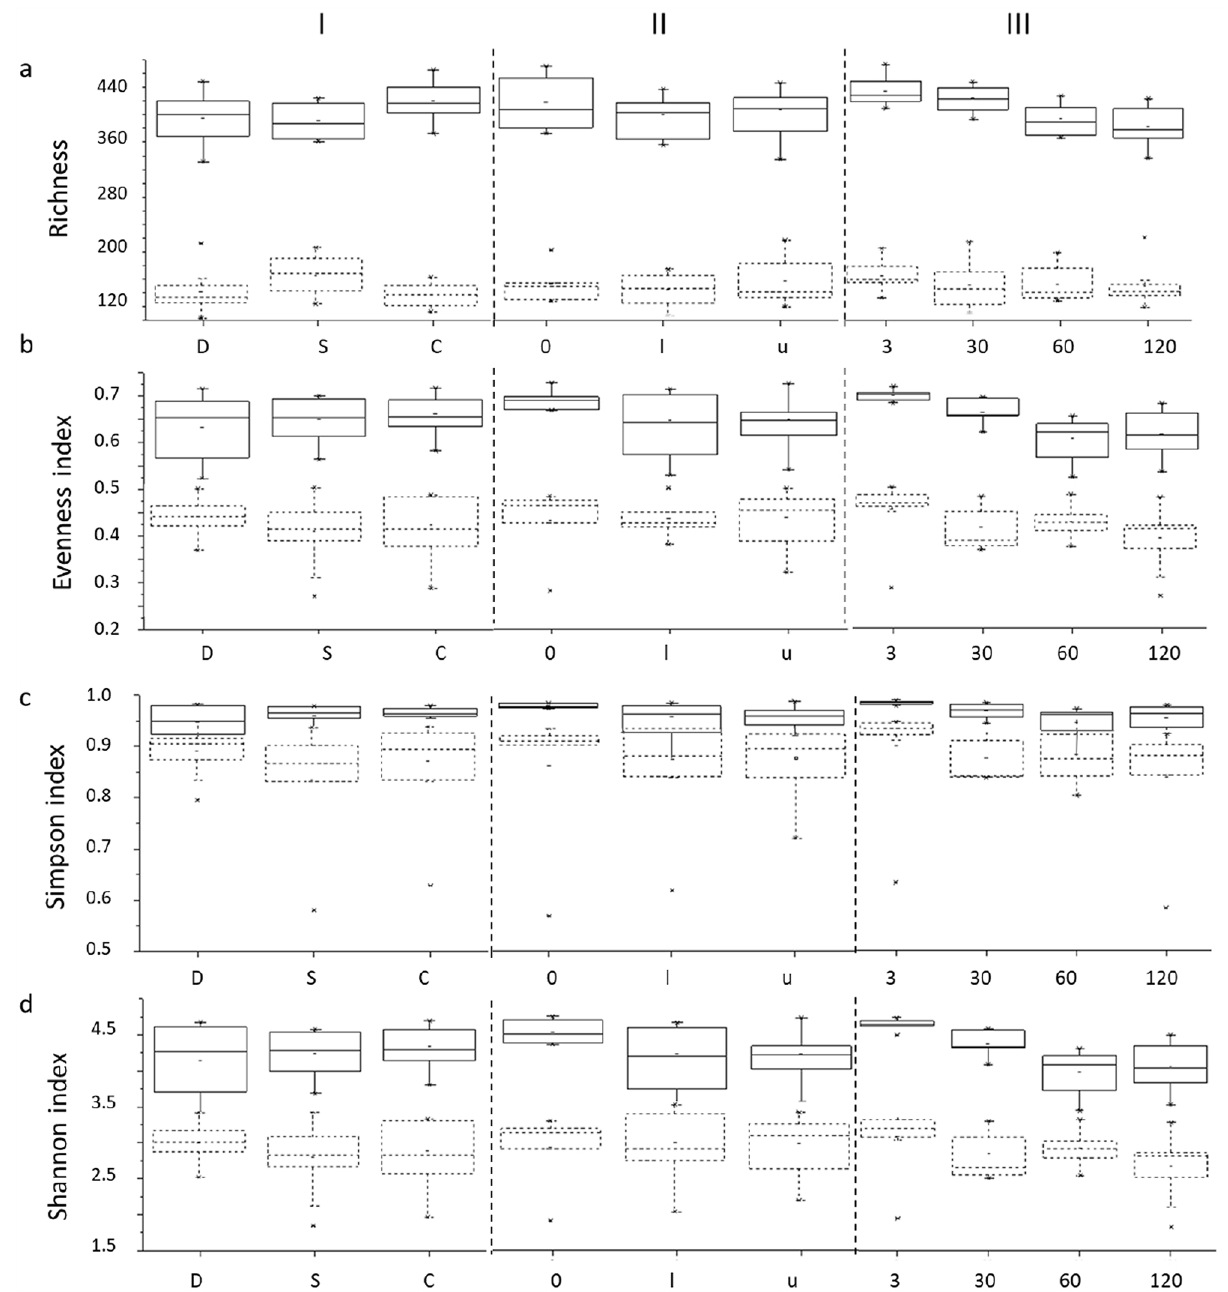
Figure 9. Beta diversity of bacterial ( a ) and fungal ( b ) communities in the initial and petroleum-polluted soils as revealed by NMDS